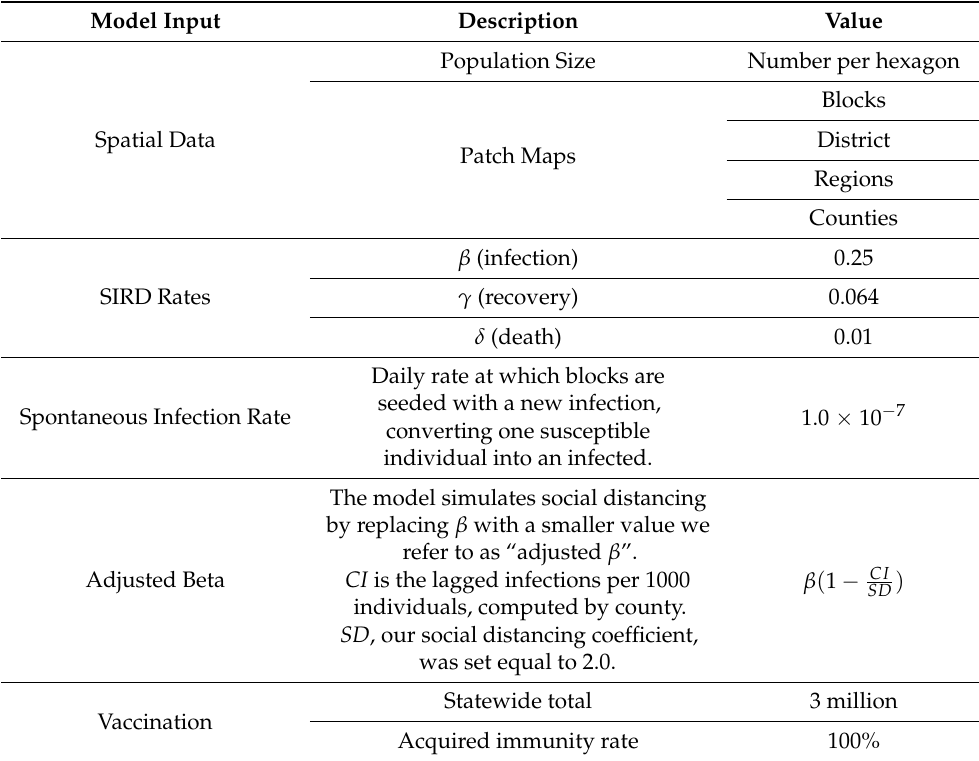
Table 2. Data and parameters required by the simulation